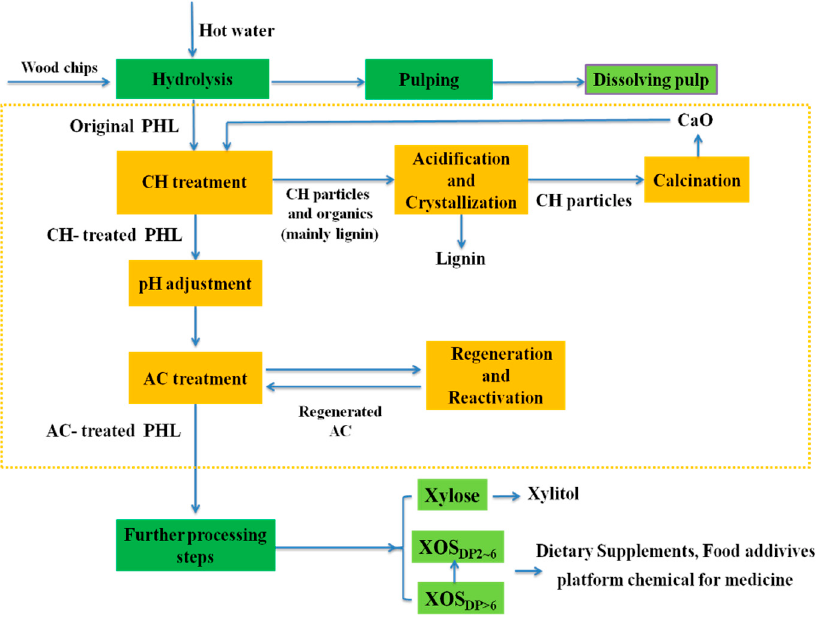
Figure 6. Proposed process for the purification and recovery of XOS from PHL.